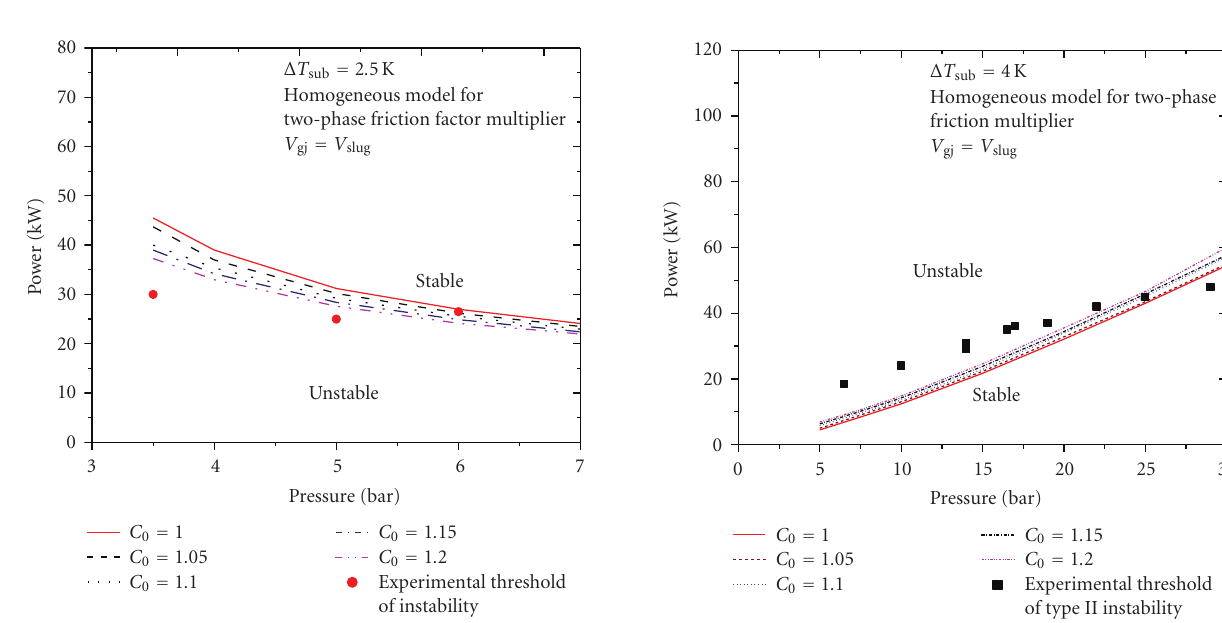
Figure 11: E ff ect of void distribution parameter on threshold of Type II instability observed in the Apparatus-A of Furutera.